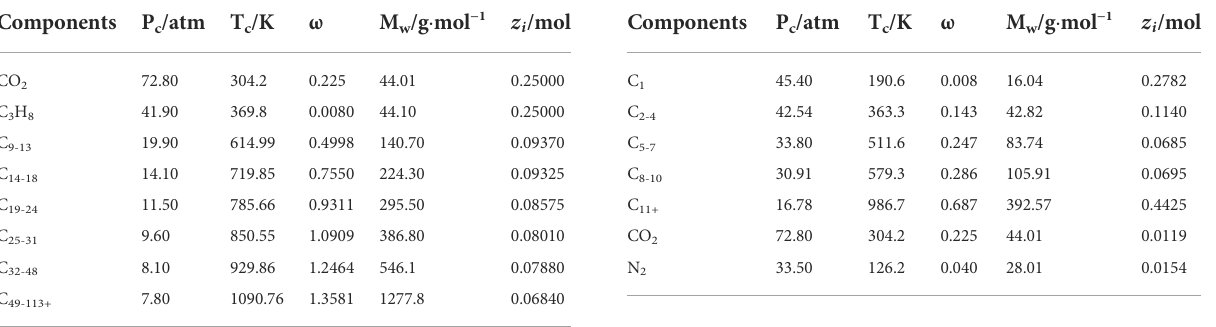
TABLE 6 The physical property parameters of an oil sample of C 3 H 8 - CO 2 -heavy oil systems from Huabei oil fi eld.